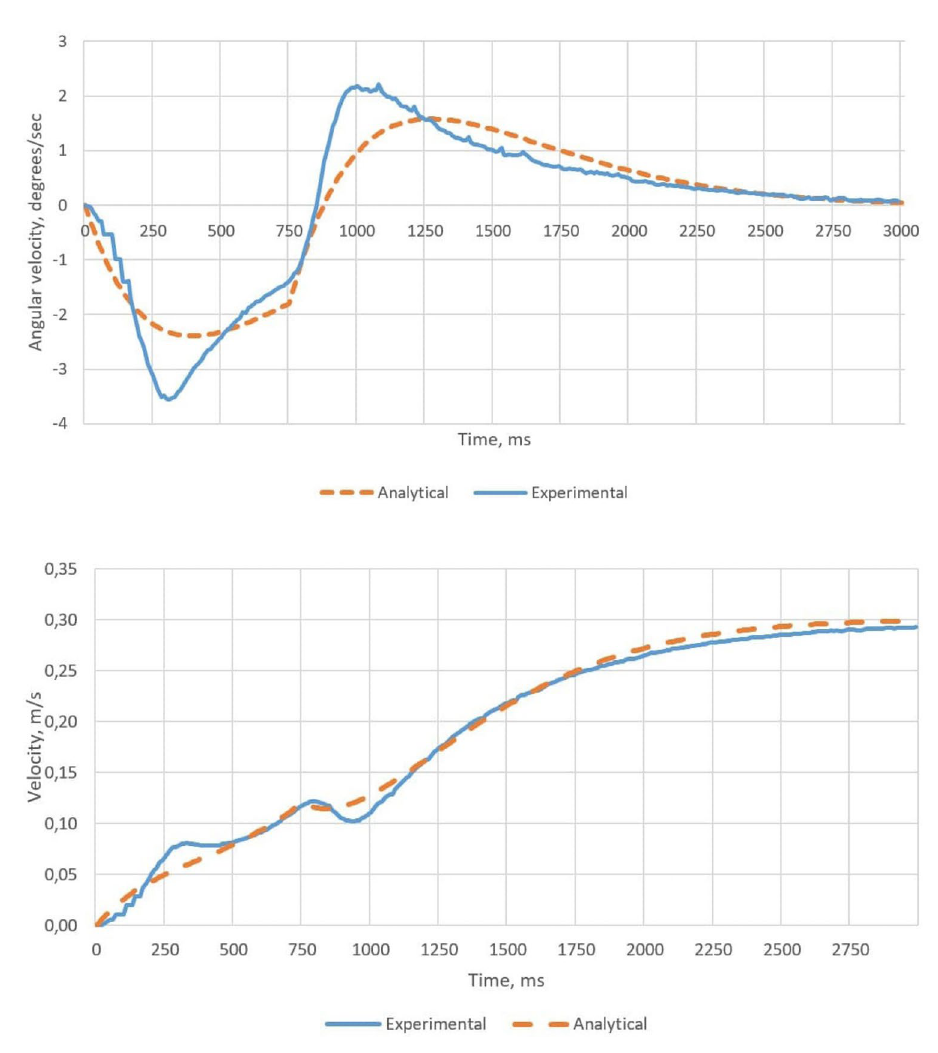
Fig. 5 Angular velocity of the rope